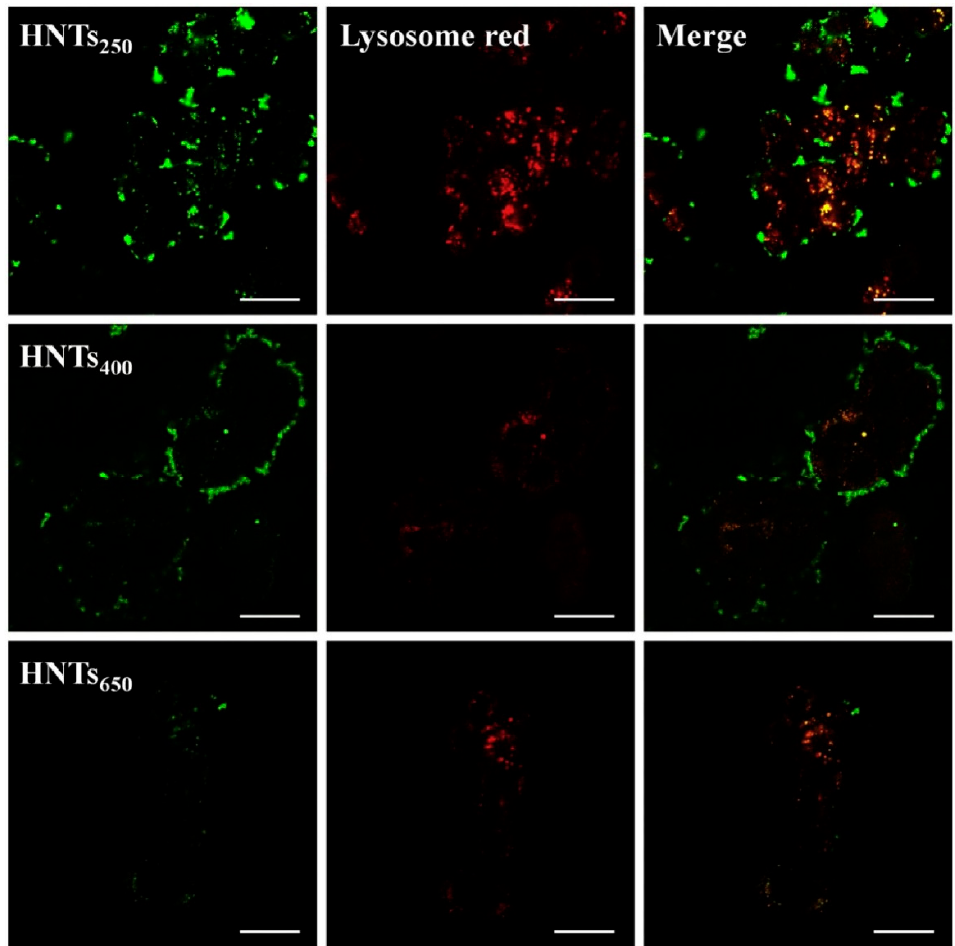
Figure 3. Intracellular uptake and subcellular distribution of HNTs 250 , HNTs 400 , and HNTs 650 with HT-29 cells. Scale bar = 25 µm. Reprinted from Colloids and Surfaces A , Vol. 585, Juan Liao, Siyu Peng, Mei Long, Yaya Zhang, Huaming Yang, Yi Zhang, Jing Huang, Nano-Bio interactions of clay nanotubes with colon cancer cells, No. 124242, Copyright (2020), with permission from Elsevier.